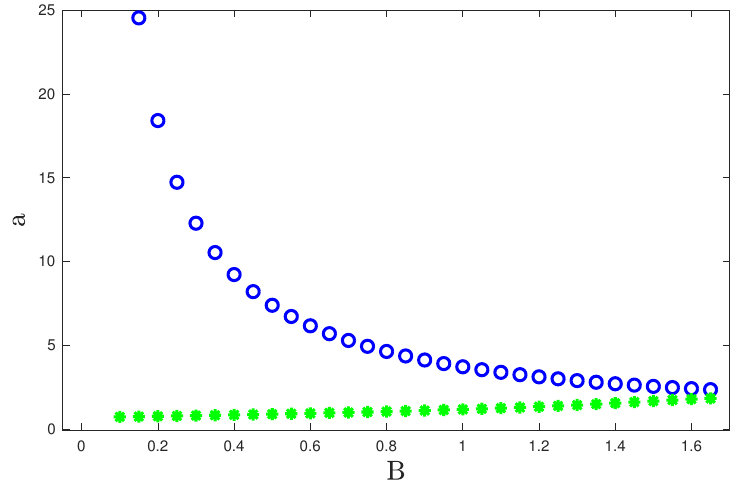
Figure 8. The blue dots represent the value of a at the edge of the surface of section, and the green stars represent the largest of the two absolute a values for the periodic orbit. ( E =